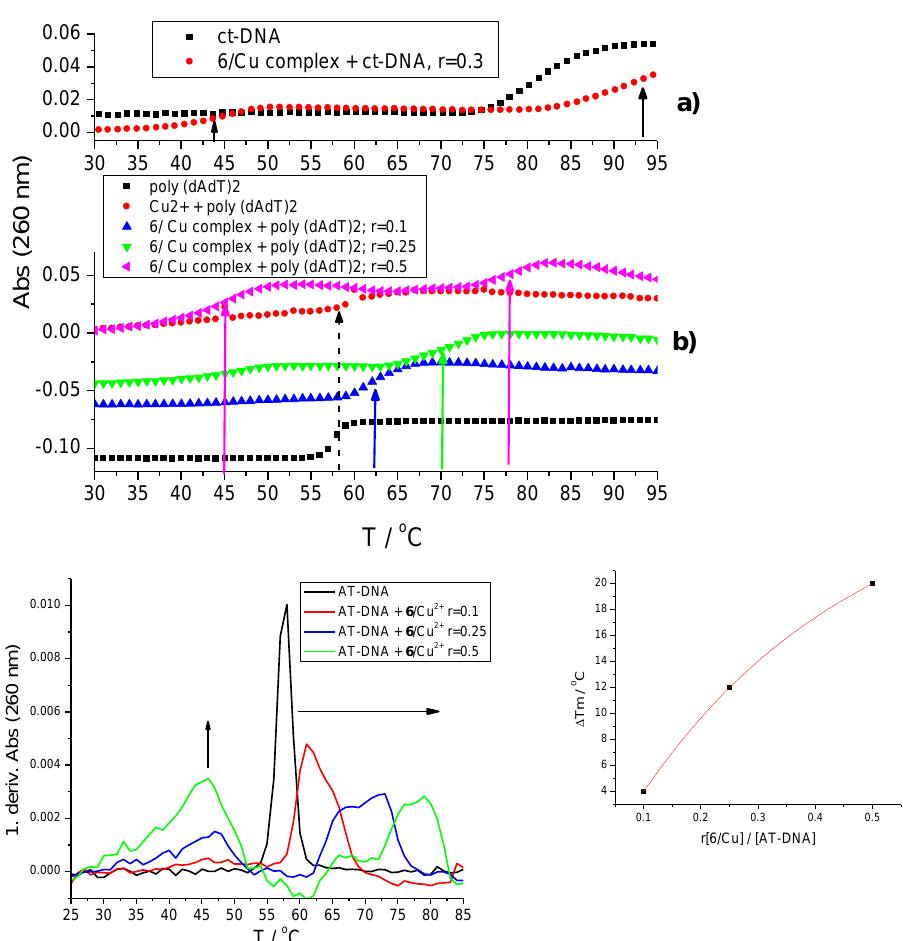
Figure 5. ( UP ) Thermal denaturation curves of ( a ) ct−DNA ( c (ct-DNA) = 2.5  10 −5 M, r [ 6/Cu) ]/[ct-DNA] = 0.25) and ( b ) poly dAdT−poly dAdT ( c (AT−DNA) = 2.5  10 −5 M, r [ 6/Cu) ]/[AT-DNA] = 0.1; 0.25; 0.5. Per- formed at at pH = 7.0, sodium cacodylate buffer, I = 0.05 M. ( DOWN ): ( left ) The first-derivative analysis of the AT−DNA experiment results; ( right ) dependence of the stabilisation effect (∆ Tm ) on the ratio r of [ 6